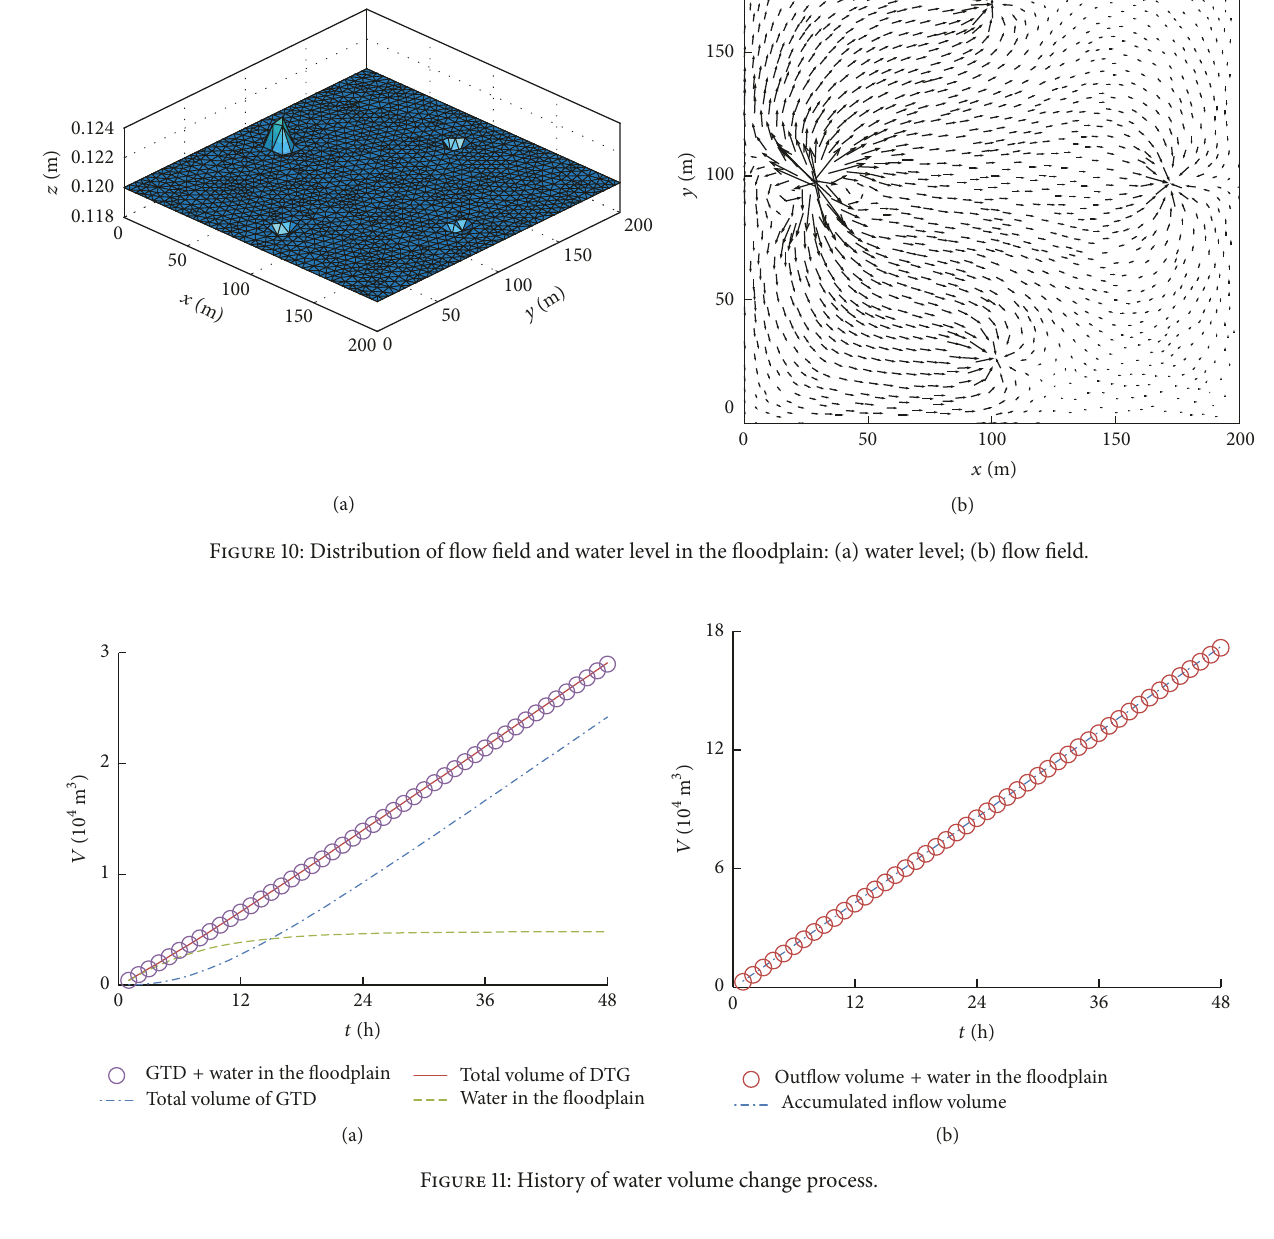
Table 5: Depth of nodes after results